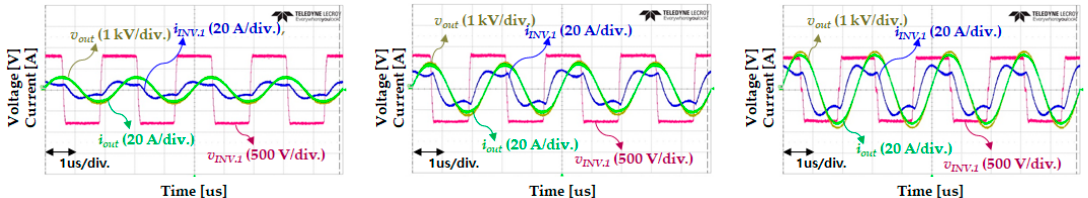
Figure 9. Waveforms in the maximum output condition according to the number of operating inverters.